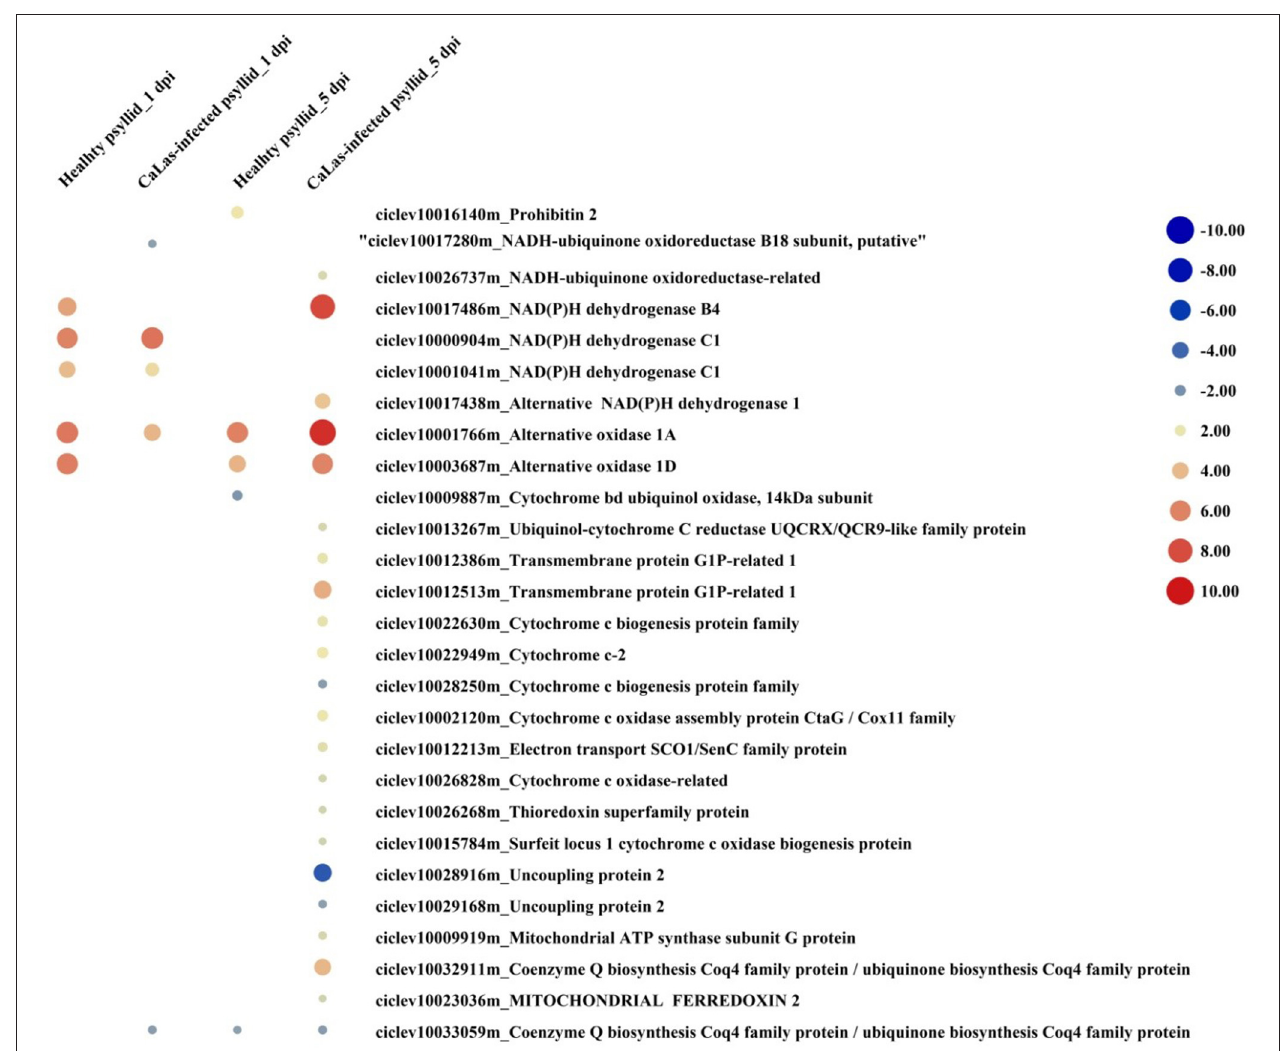
FIGURE 7 | The red-blue heatmap of modulated DEGs involved in ATP biosynthesis pathways. Each DEG is depicted by a color signal where red signifies upregulation and blue signifies downregulation. The size of each spot indicates the level of